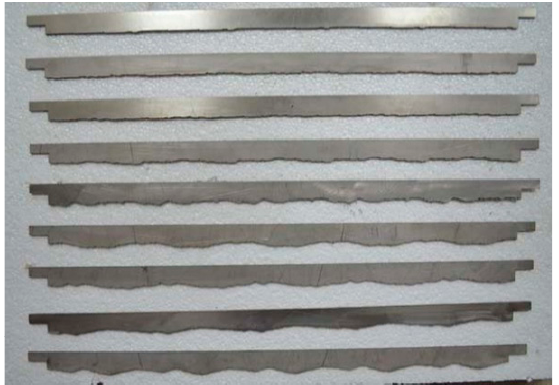
Figure 4. Steel sheets with Bardon’s roughness profiles.